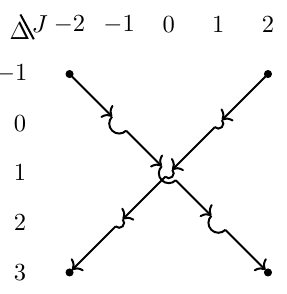
Figure 5 . Celestial ‘Diamonds’ for the Sub-subleading Soft